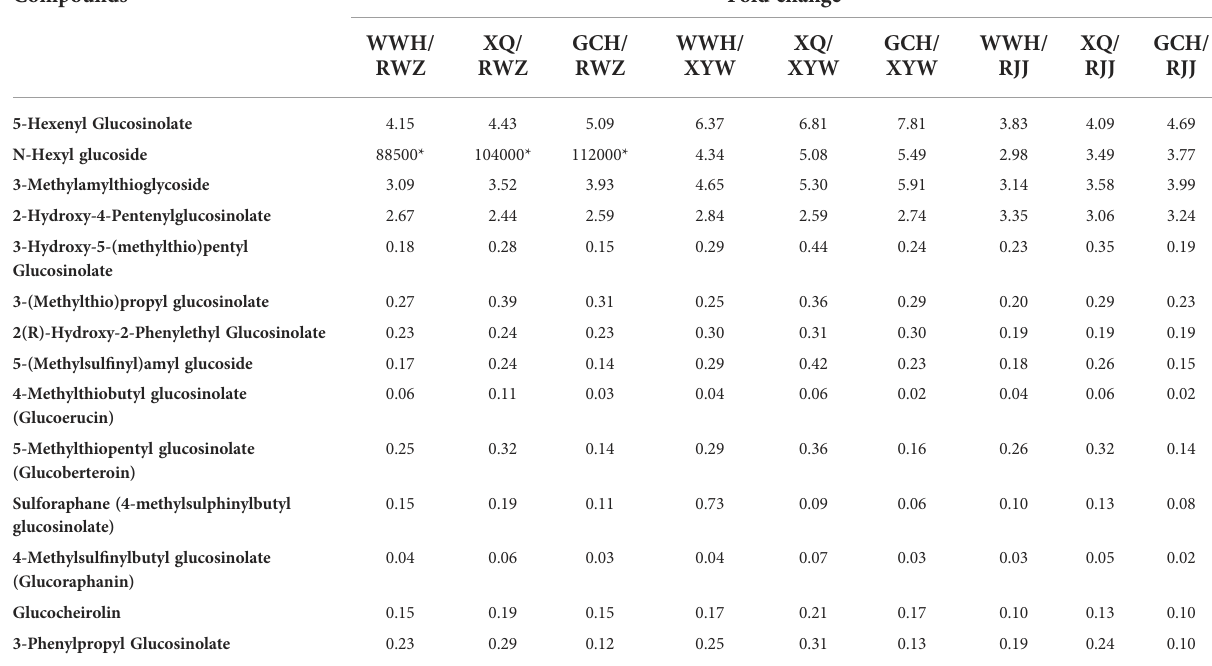
TABLE 1 Compares glucosinolate content between yellow inner-leaf Chinese cabbage and white inner-leaf Chinese